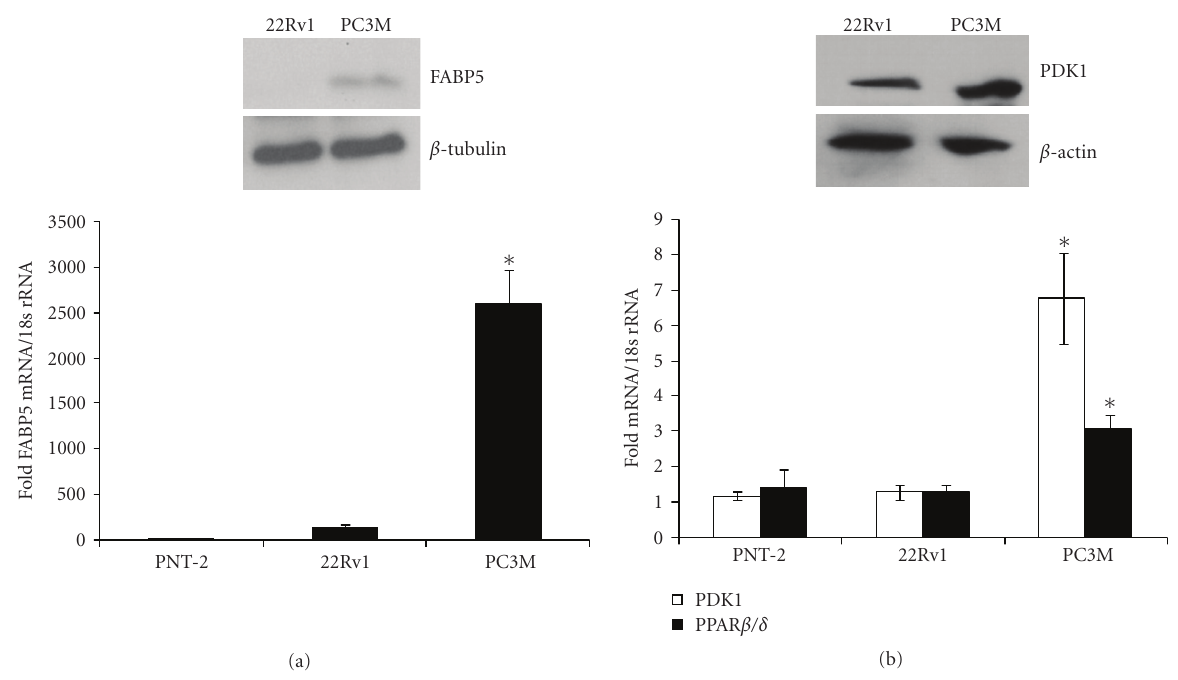
Figure 1: Prostate cancer progression is accompanied by up regulation of FABP5/PPAR β/δ expression and signalling. (a) Bottom: Expression levels of FABP5 mRNA in denoted cell lines were measured by Q-PCR. Top: Level of FABP5 protein in denoted cell lines assessed by immunoblots. (b) Bottom: Expression levels of PDK-1 and PPAR β/δ mRNA in denoted cell lines were measured by Q-PCR. Top: Immunoblots of PDK1 in denoted cell lines. Data are mean ± S.D. ( n = 3). ∗ P < . 02 versus 22Rv.1. (Paired T test). Immunoblots were repeated three times with similar